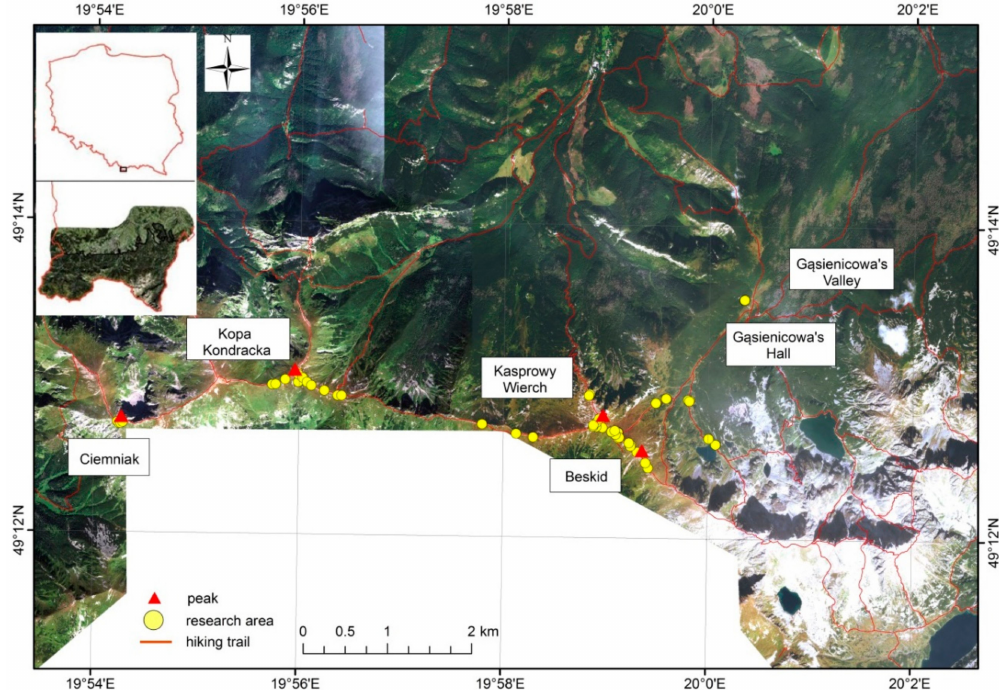
Figure 1. Location of the research area and polygons (in the background the WorldView2 image, 2015, the vector data acquired from the Tatra National